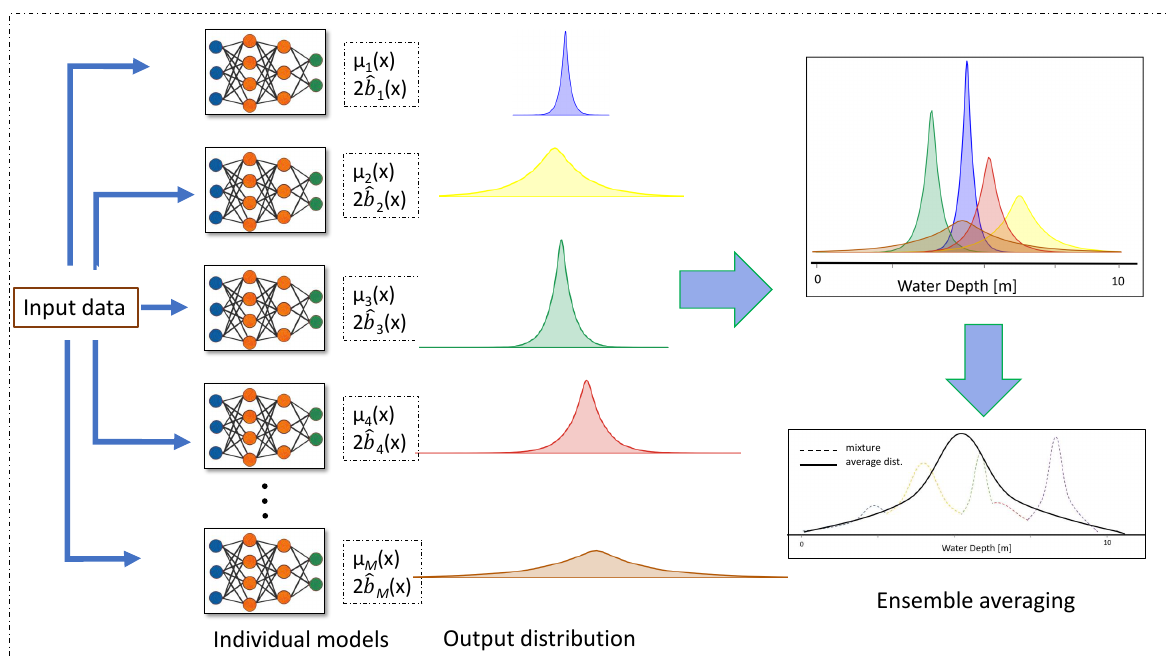
Figure 1. High-level illustration of our proposed approach, Deep Flood , for prediction of flood hazard maps. The input data containing parameters of the terrain and rainfall forecast is fed to the deep learning model during the training phase. All models are identical but trained independently starting from random initial weights. Each model outputs a pixel-wise maximum water depth µ and scale parameter 2 b . The outputs are then combined providing the final estimate of the water depth map together with its associated predictive